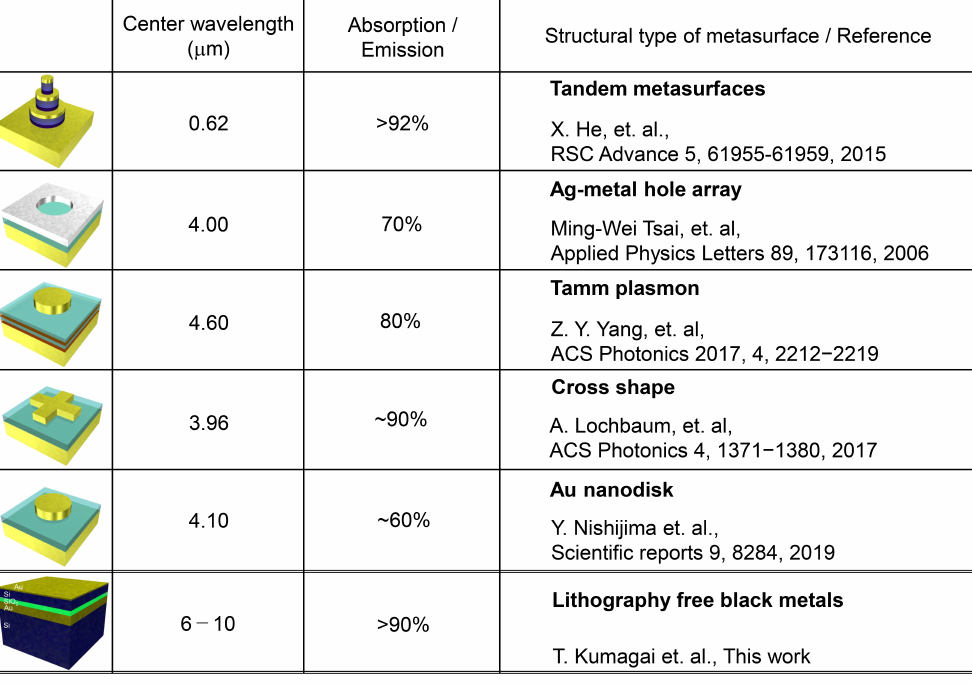
Figure 7. Comparison of the absorption and thermal radiation that reported in the reference